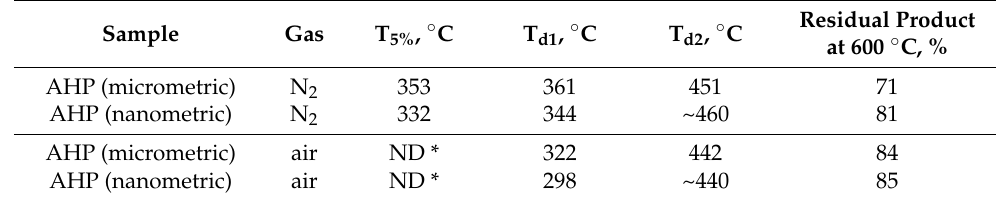
Figure 1. ( a , b ). Selected images of AHP before and after grinding: ( a ) SEM of as-received microparticles before grinding; ( b ) STEM of nanoparticles obtained by the two successive grindings. Table 1. TGA results obtained following the characterization of AHP (micro- and nanoparticles) under nitrogen and